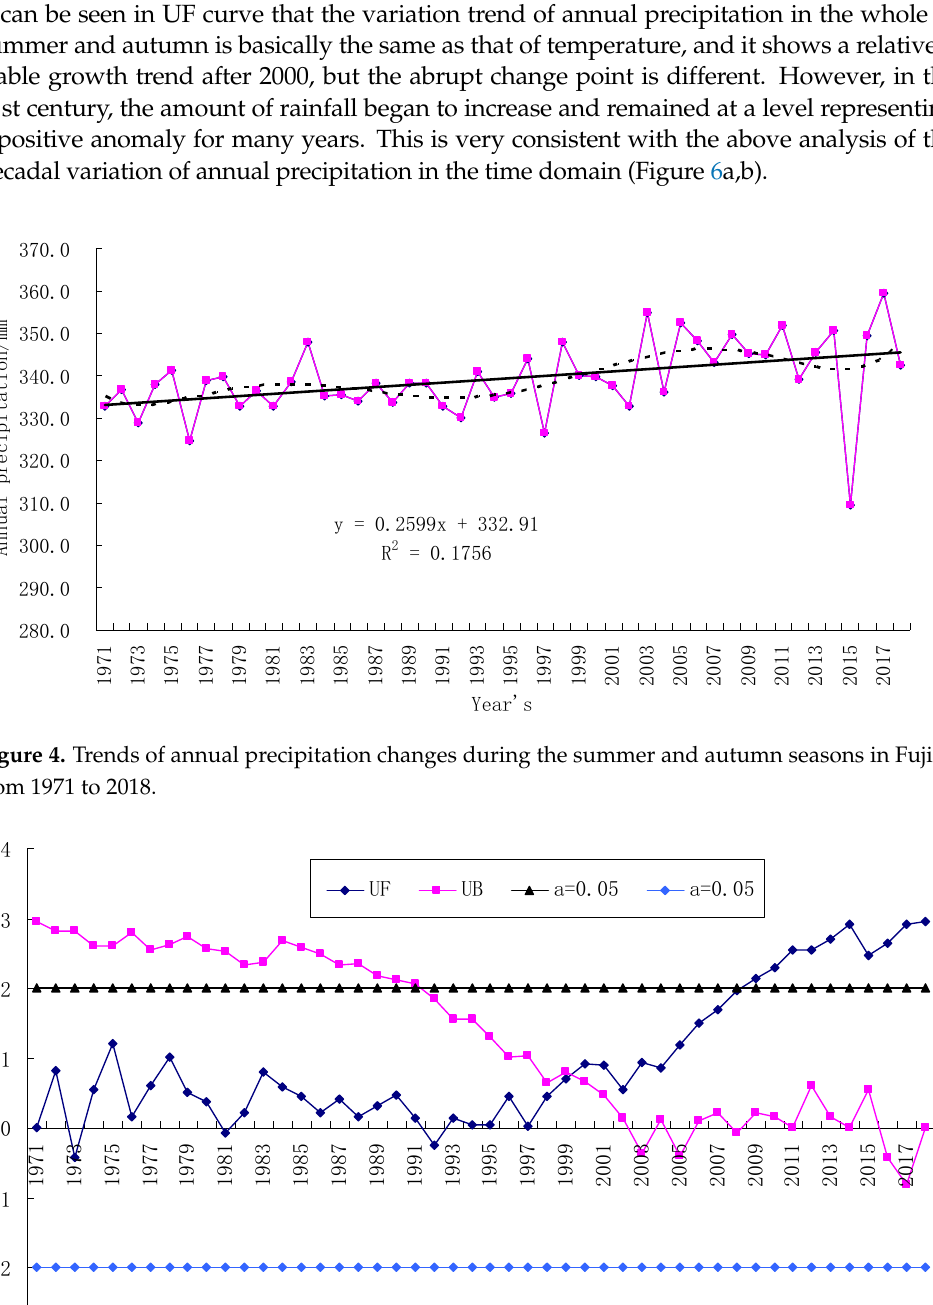
Figure 5. M-K test of the trends of annual precipitation changes during the summer and autumn seasons in Fujian from 1971 to 2018.